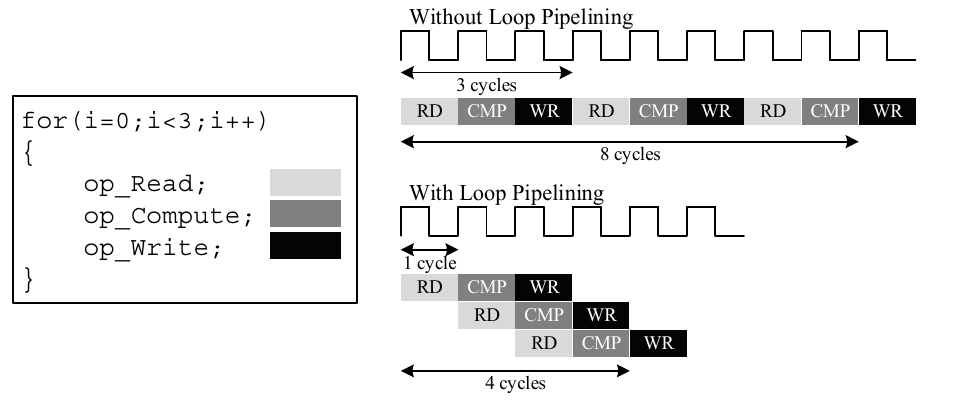
Figure 7. Loop pipelining optimization.